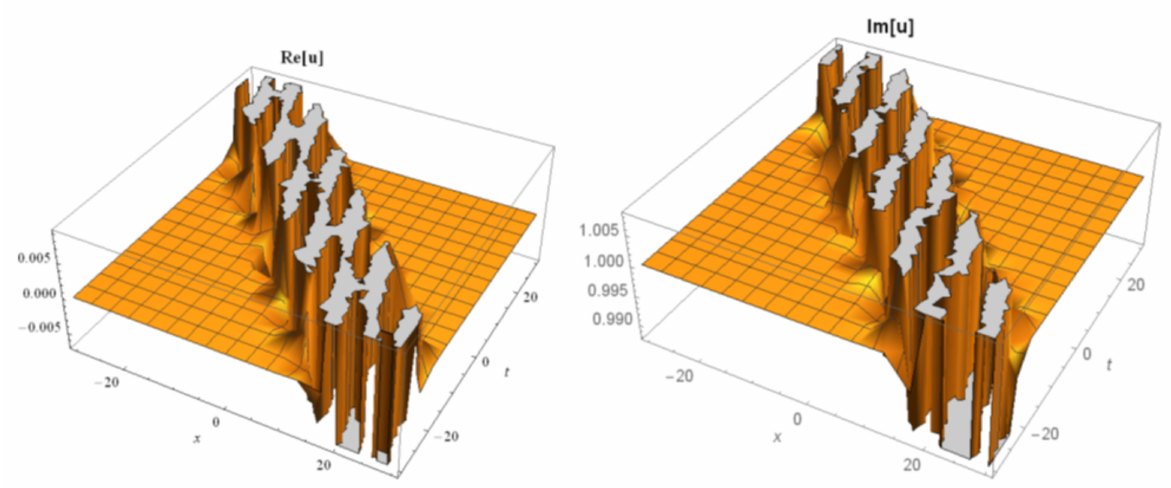
Figure 5. The 3D surfaces of Equation (20) under the values of ε = 0.4, − 30 < x < 30, − 30 < t < 30.